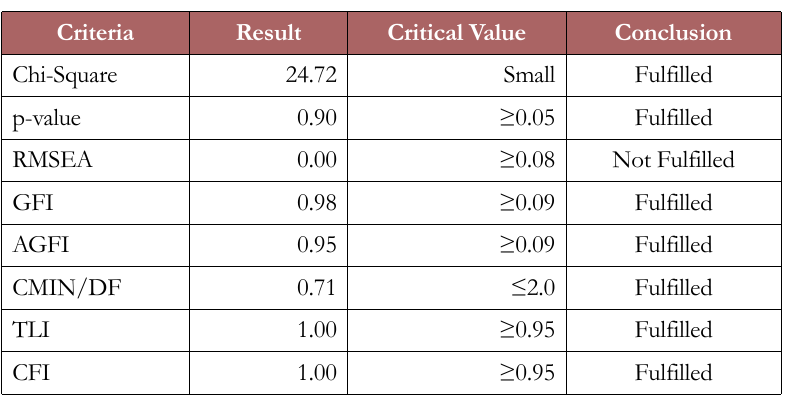
Table 2. Goodness of Fit Result